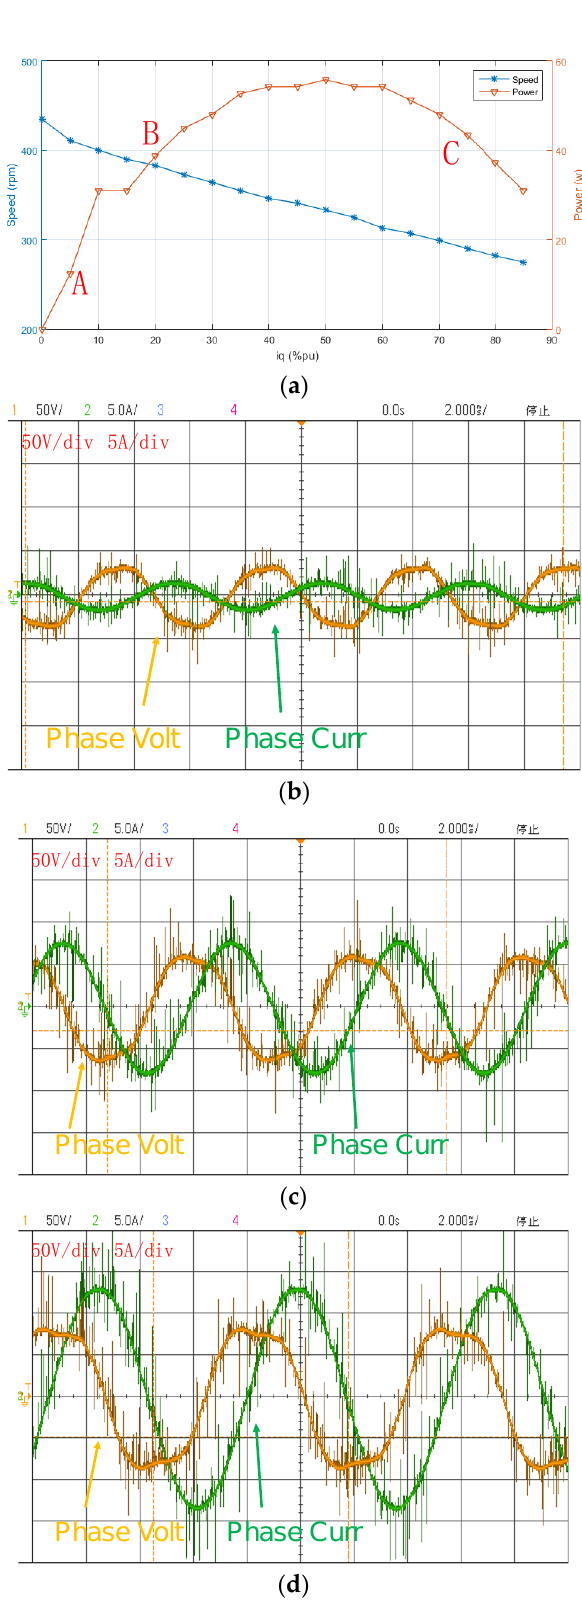
Figure 14. Generation system performance around 400 rpm. ( a ) DC motor speed, iq command value and system output power; ( b ) Phase voltage and current at point A; ( c ) phase voltage and current at point B; ( d ) Phase voltage and current at point C.